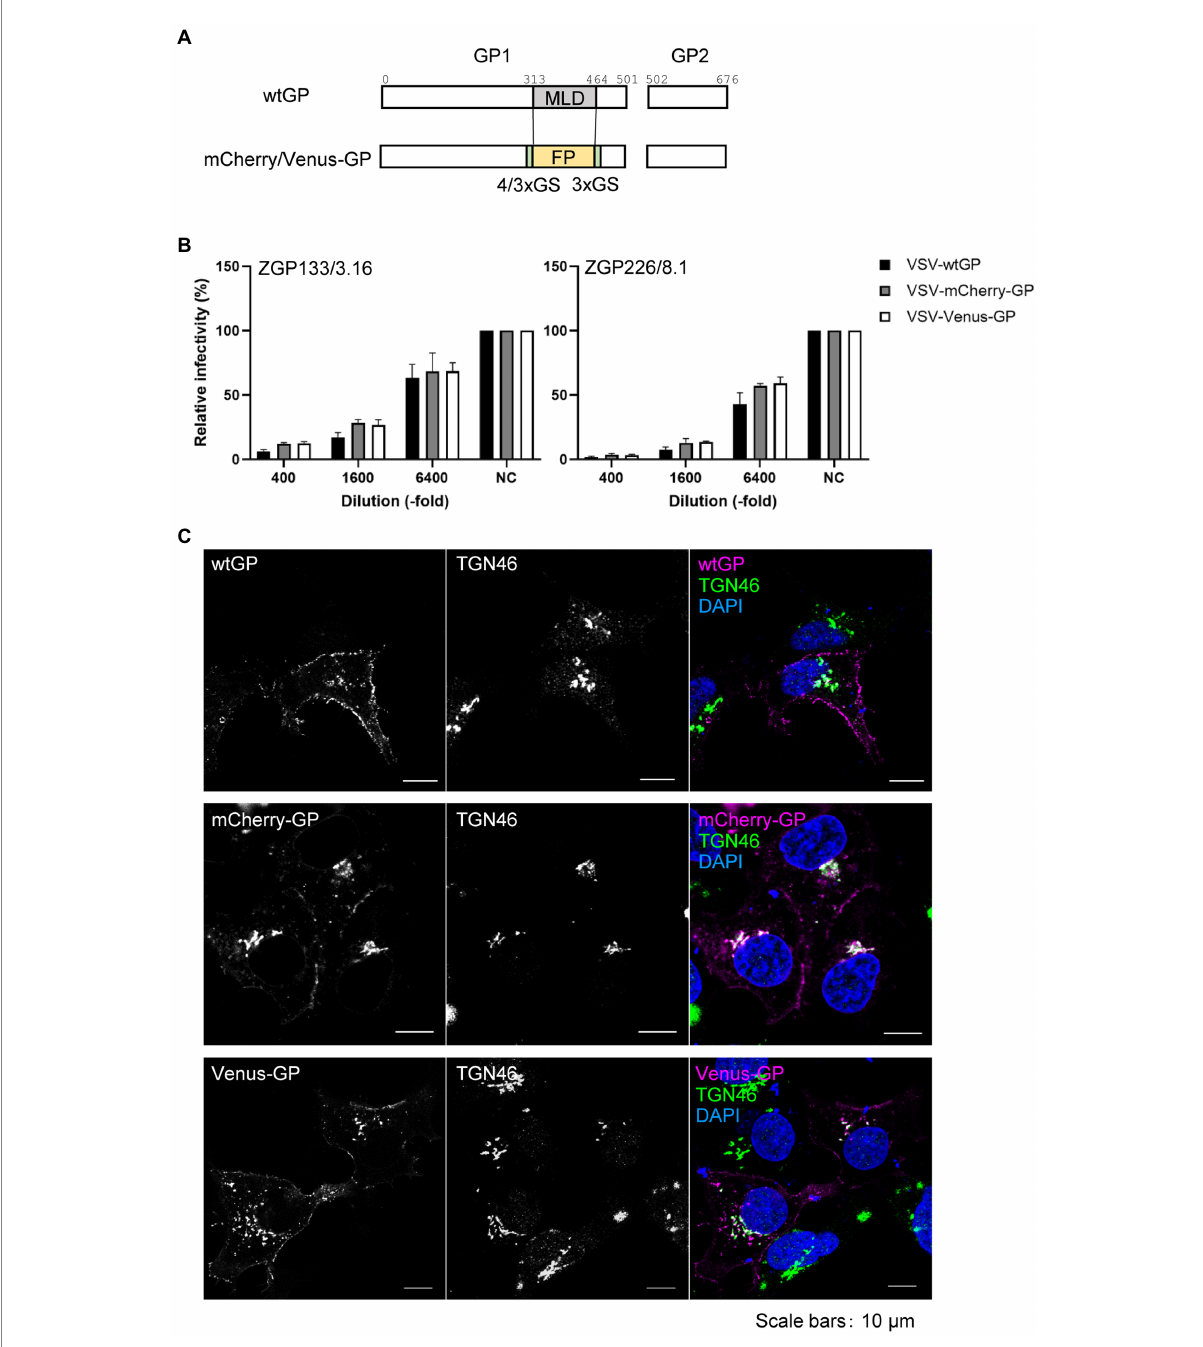
FIGURE 1 Fluorescent protein-fused GP retained its function and intracellular distribution. (A) Schematic representation of fluorescent protein-fused GP. MLD, Mucin-like domain; FP, fluorescent protein; GS; glycine-serine linker. Amino acid positions for the MLD are shown. (B) Neutralization assay of the VSV pseudotyped with fluorescent protein-fused GP. VSV pseudotyped with the indicated GPs were incubated with monoclonal antibodies, ZGP133/3.16 or ZGP226/8.1, followed by inoculation into Vero E6 cells. The relative infectivity is shown by setting the IU in the absence of neutralizing antibody. The mean and standard deviation of three independent experiments are shown. (C) Intracellular distribution of wild-type, mCherry-, or Venus-fused GP. HEK293 cells were transfected with expression plasmids for wtGP (top), mCherry-GP (middle), or Venus-GP (bottom). The cells were harvested at 24 hpt and distribution of individual GP derivatives (left, magenta in the merged images) and TGN46 (middle, green in the merged images) were analyzed by immunofluorescence staining. The nuclei were counterstained with DAPI (blue in the merged images). Scale bars: 10 μ